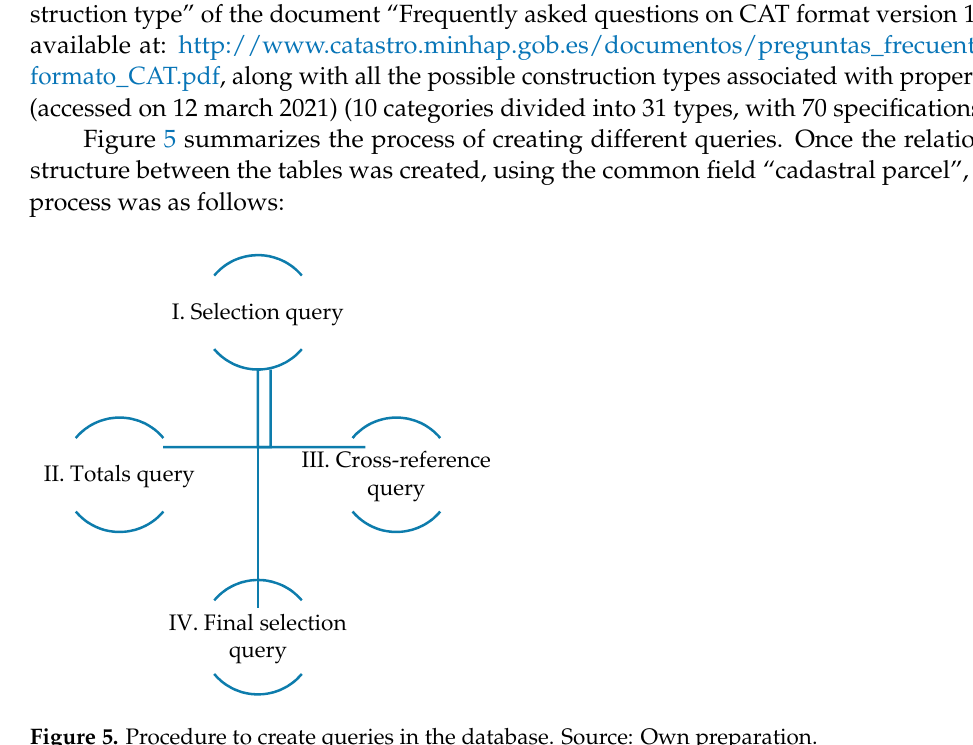
10 of 23 Table 2. Construction types selected 1 .